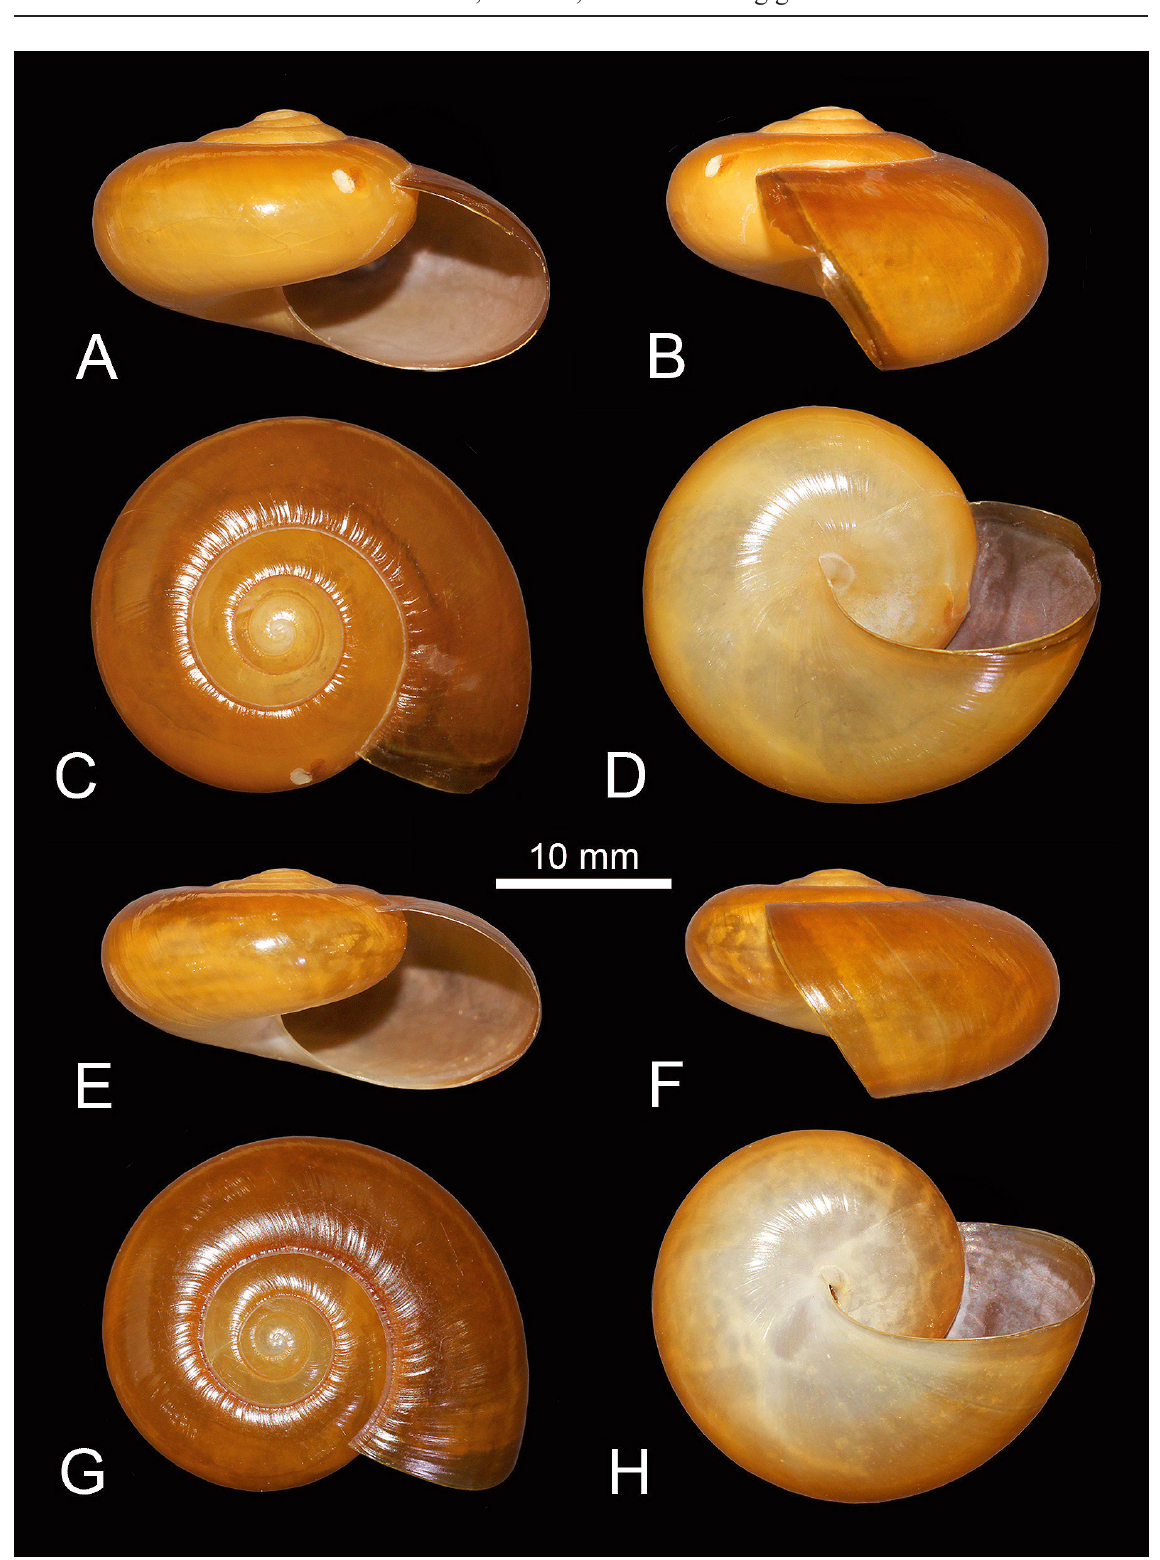
Fig. 3. Apertural, lateral, apical and umbilical views of the shell of Varadia amboliensis Bhosale, Thackeray, Muley & Raheem gen. et sp. nov. A–D . Holotype (BNHS GAS 113). E–H . Paratype (BNHS GAS